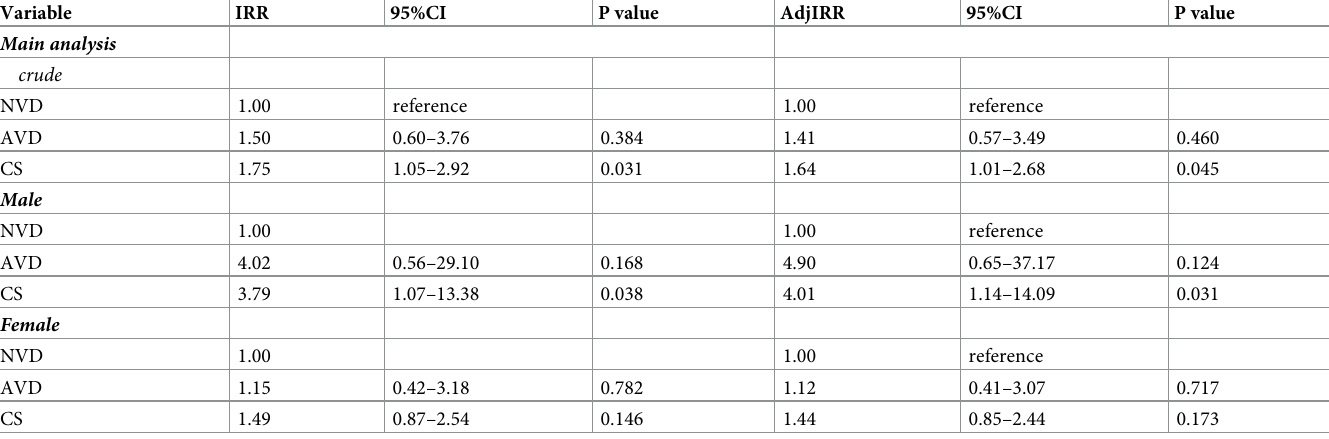
Table 6. The association between mode of delivery and early adulthood obesity, stratified by sex and birth weight (using normal BMI as reference)-Imputed models.